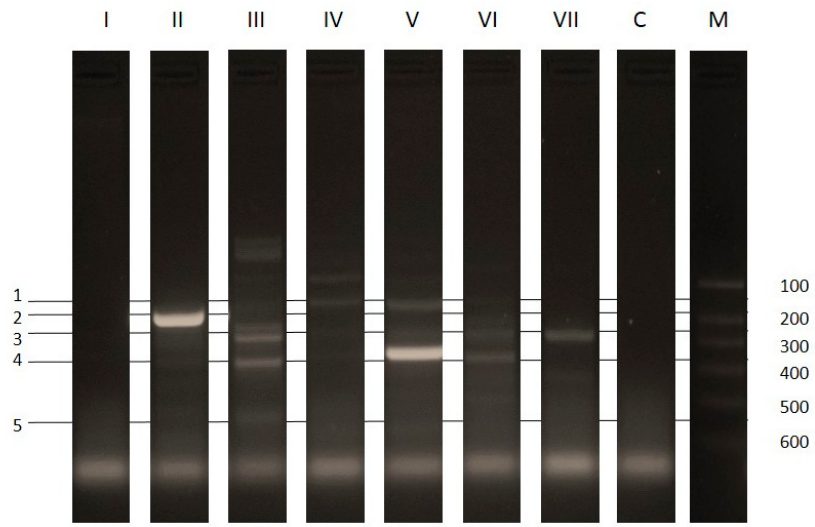
Figure 4. Multiplex PCR of plasmid DNA: Lane I–VII strains (I— Gemella haemolysans ; II— Macrococcus equipercicus ; III— Macrococcus brunensis ; IV— Bacillus cereus ; V— Micrococcus luteus D; VI— Staphylococcus xylosus ; VII— Enterococcus faecium ), lane C: negative control - without template DNA; lane M: 100bp DNA ladder. Line 1–5 indicate the size of the amplification products:1-vatB (136bp), 2-ermA (190bp), 3-aacA-aphD (227bp), 4-tekK (360bp), 5-mecA (532bp).